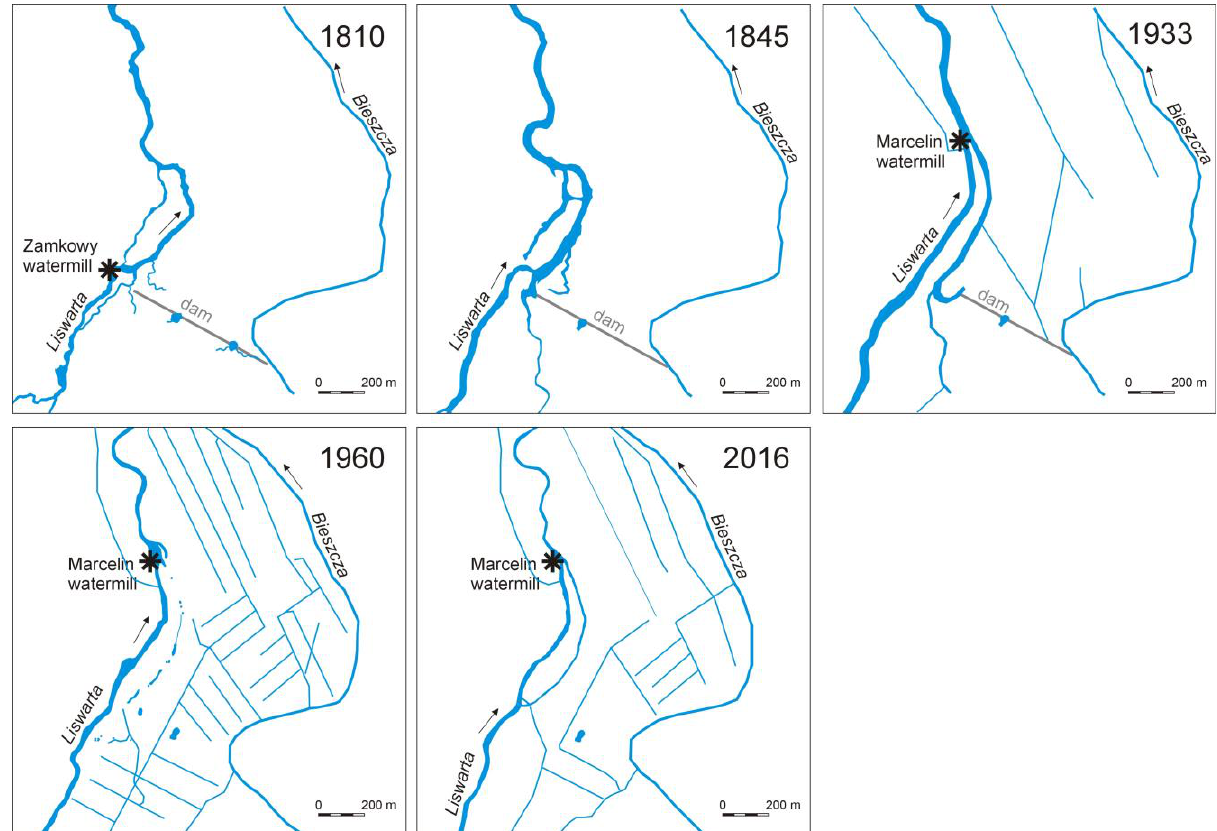
Fig. 5. Changes to the River Liswarta channel in Kuźniczka as a result of the decommissioning of the older (Zamkowy) watermill and the construction of the Marcelin mill in a new location (own